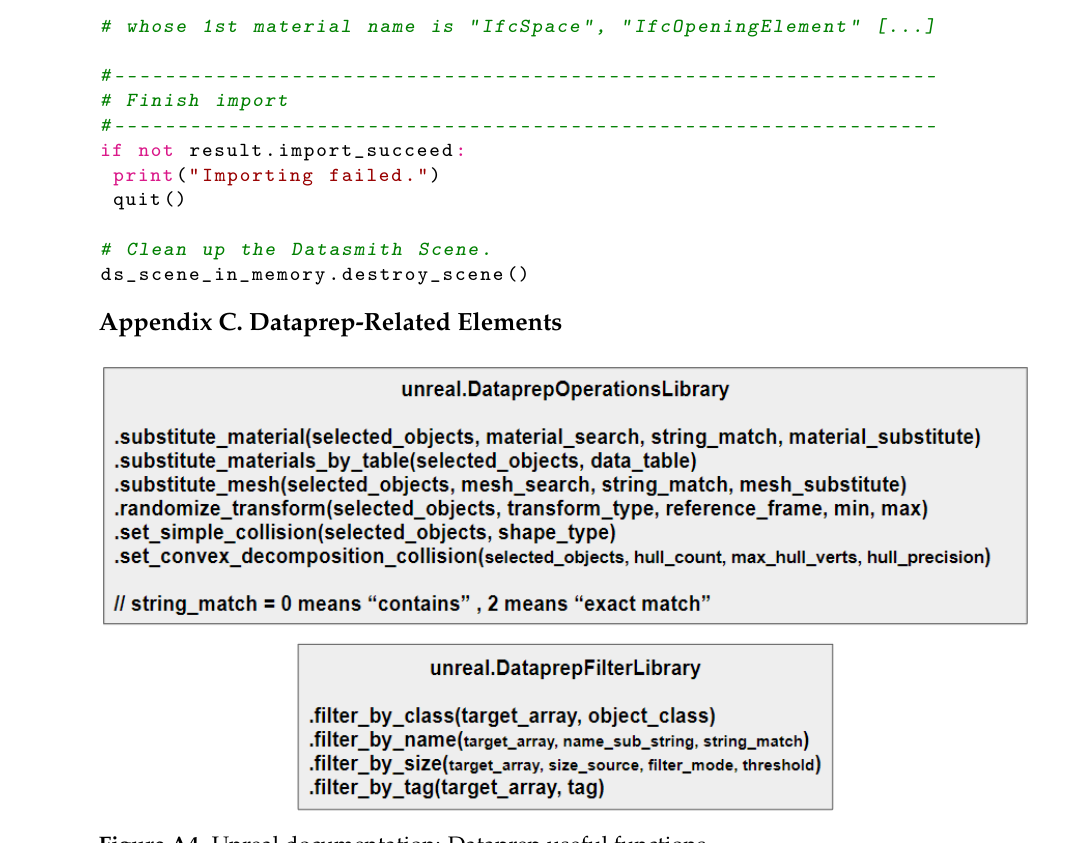
Figure A4. Unreal documentation: Dataprep useful